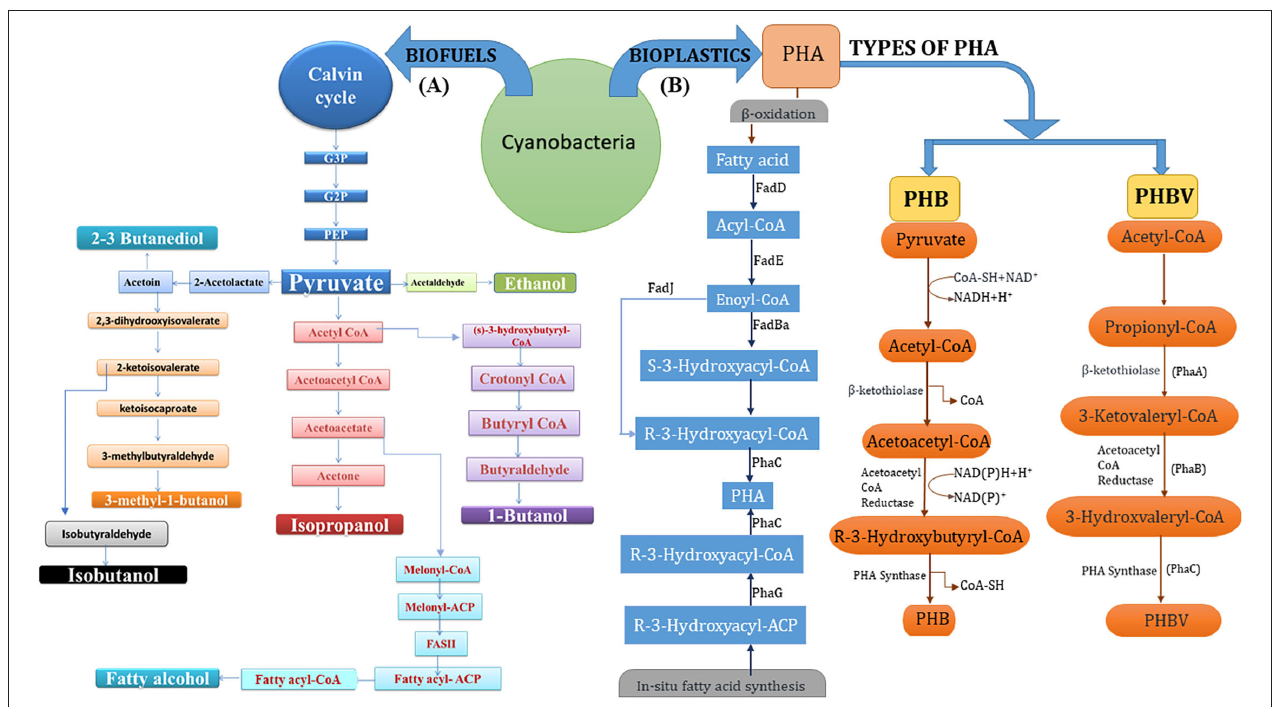
FIGURE 2 | (A) Schematic representation of cyanobacterial metabolic pathways leading to biofuel (bioethanol) derivatives viz. ethanol, butanol, isobutanol, isopropanol, 2,3-butanediol, and fatty alcohol; all derived from Calvin cycle and associated intermediate biomolecules (especially pyruvate). (B) Synthesis of PHA copolymers (PHB and PHBV) through enzyme-mediated 3-step pathway i.e., condensation, reduction, and polymerization with precursor acetyl-CoA molecules and through fatty acid β -oxidation